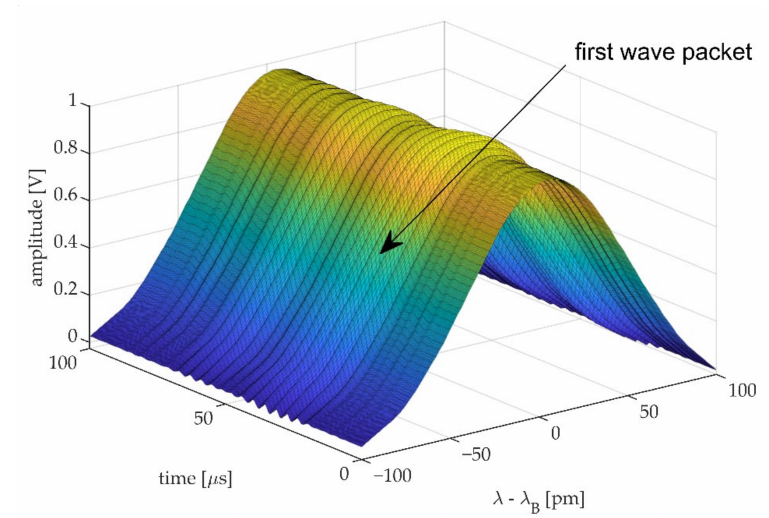
Figure 8. Full spectral reconstruction of 250 kHz UGW passing through an 8-mm FBGs. AC amplitude of the UGWs is artificially increased by a factor 10 for visualization.